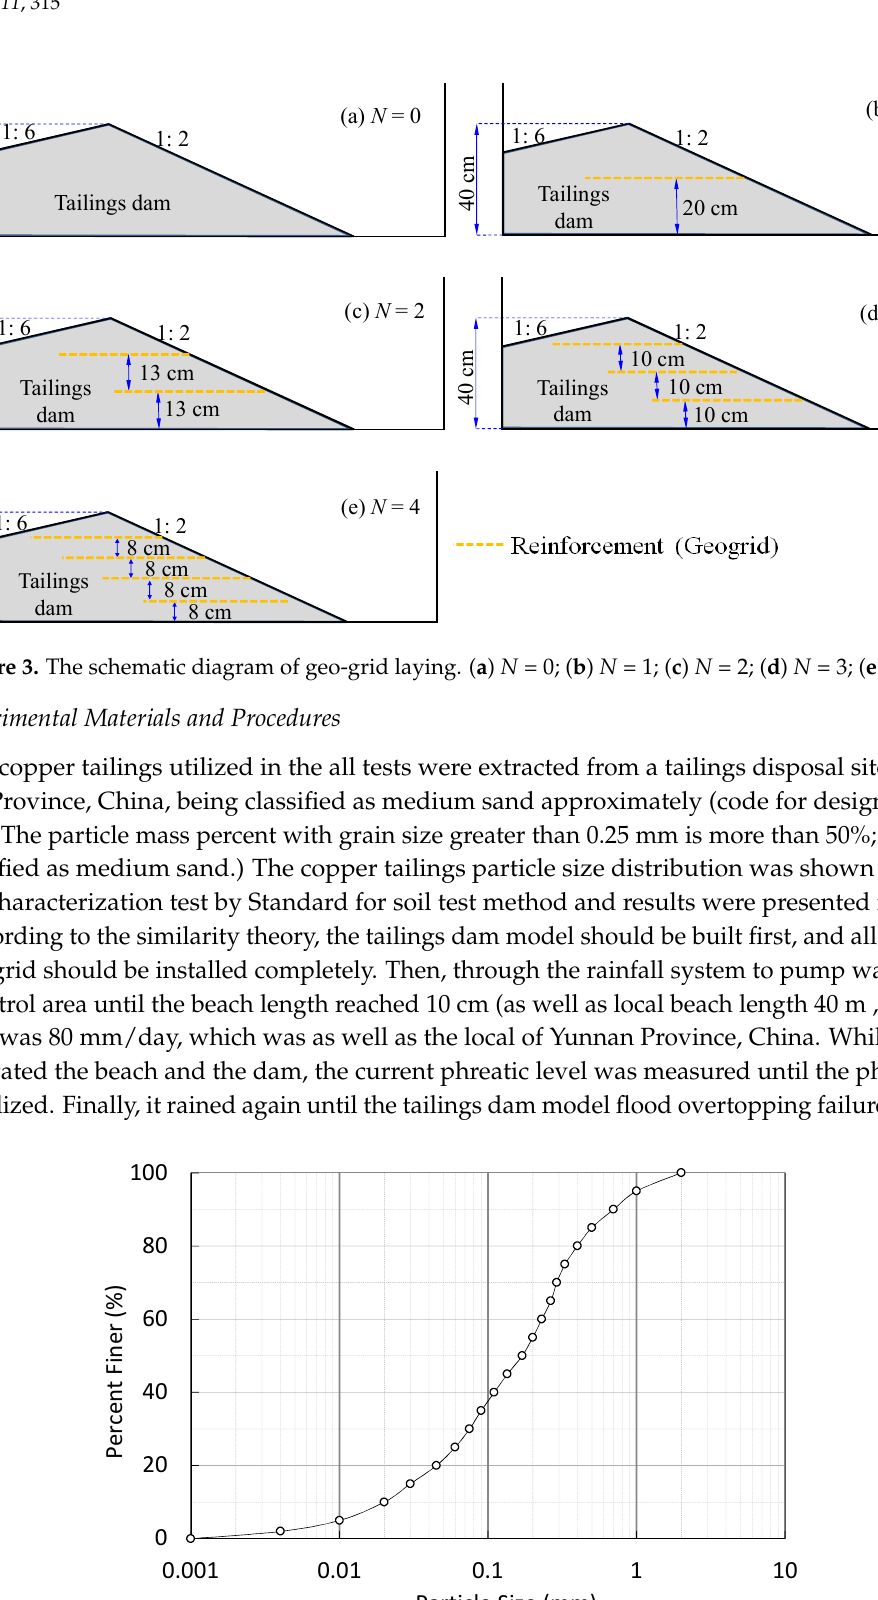
Figure 4. Grain size distribution curve of the copper tailings sample. Table 2. Properties of the copper tailings sample.